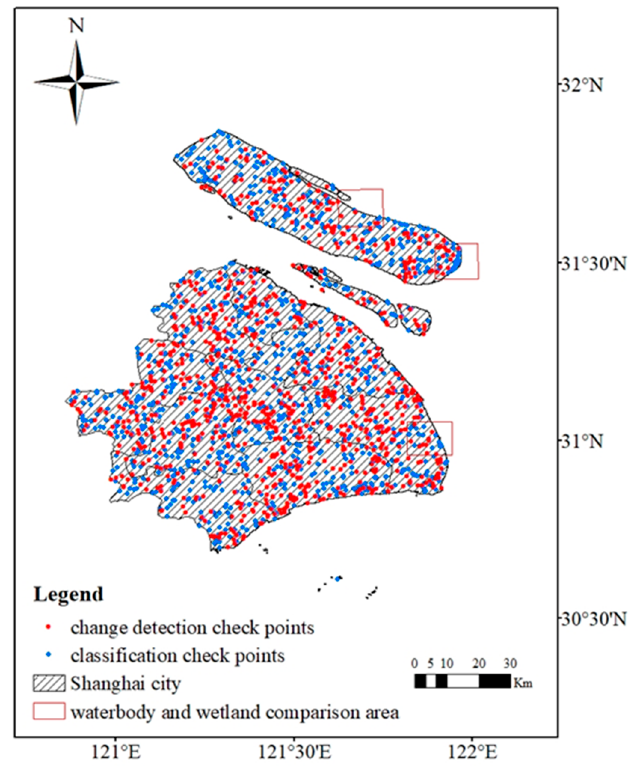
Figure 5. Distribution map of check points.